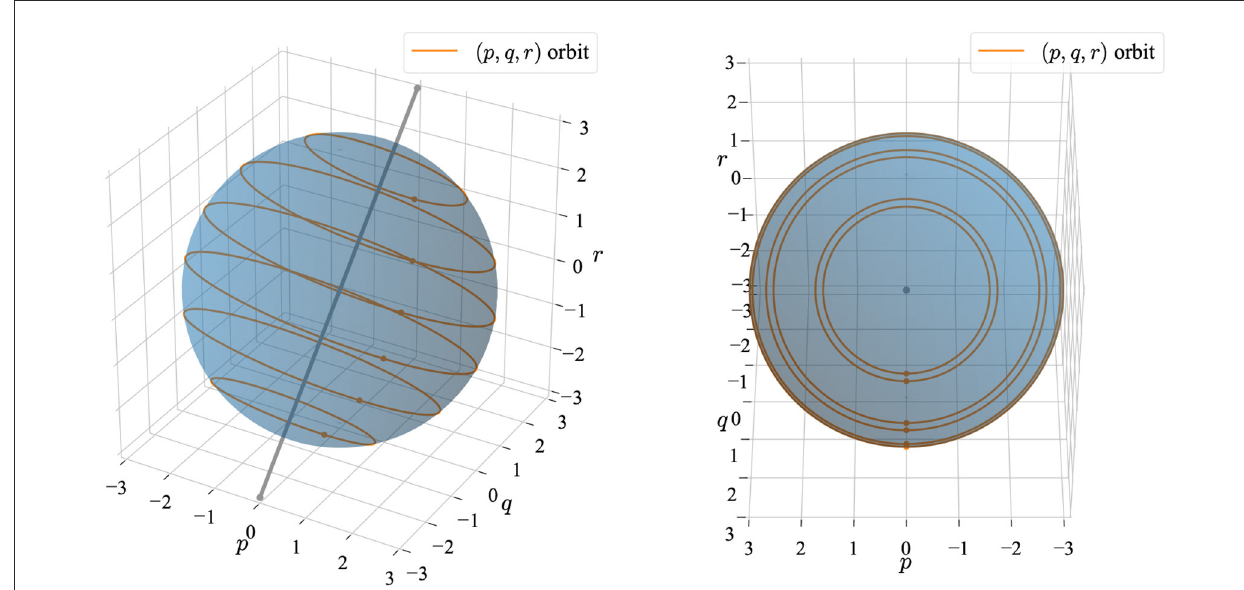
FIGURE1 Two views of the orbits (orange solid line) of the Poisson system on the phase-space ( q , p , r ). The orbits are circles (right) lying on planes (left) with normal (0,1,1) so that q + r is a constant. The blue sphere represents the constant Hamiltonian value corresponding to H = 3 2 /